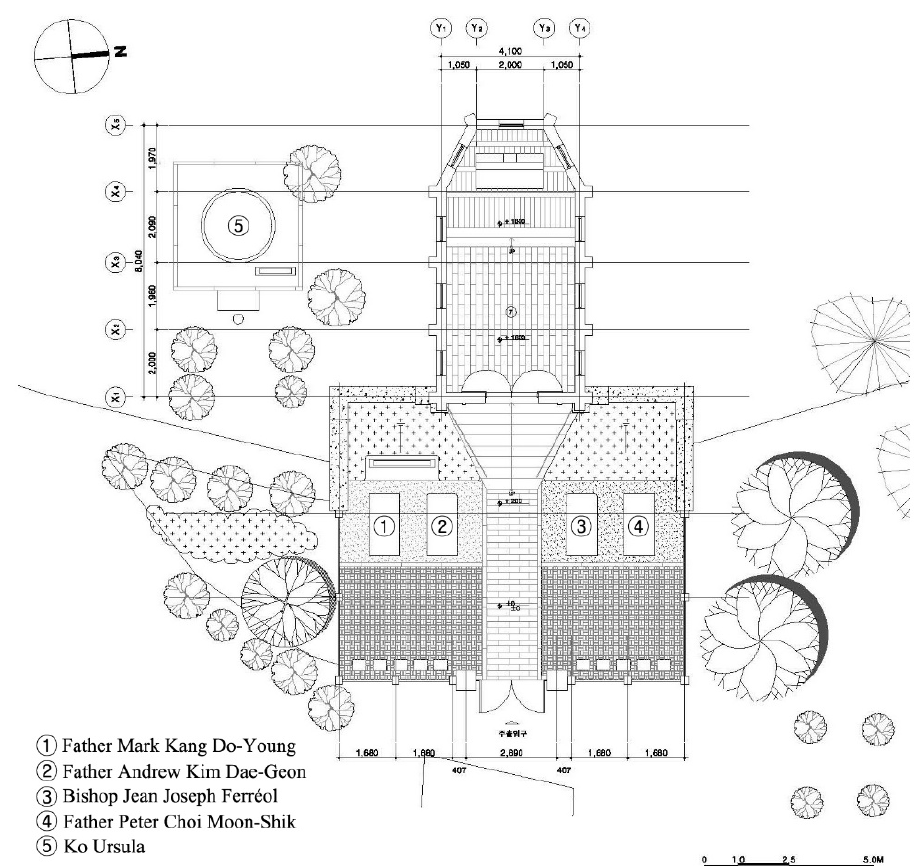
Figure 5. The interior of the Memorial Church in 2021 [source: photo by author].